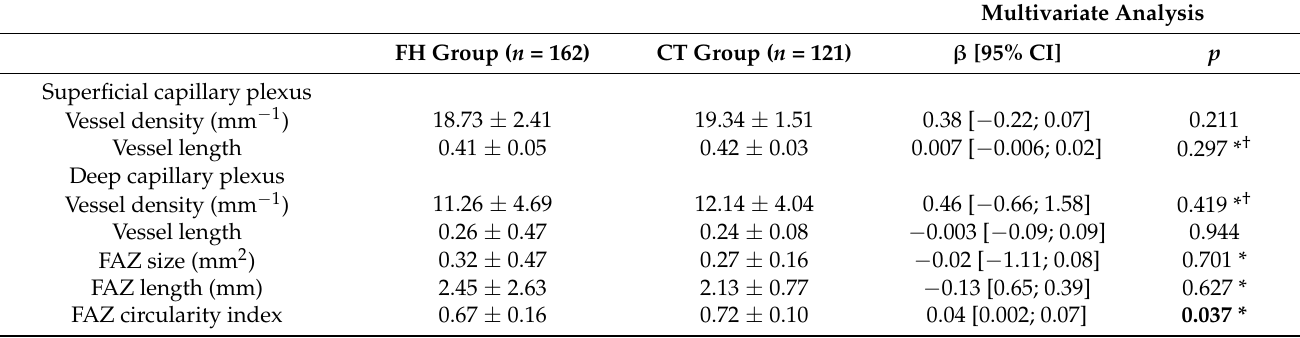
Table 3. Comparison of retinal vascular parameters between familial hypercholesterolemia and control group